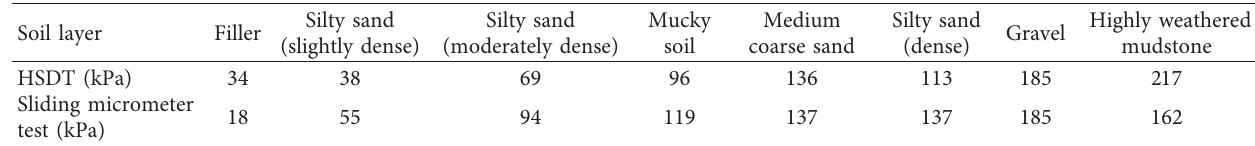
Table 5: Average values of pile side resistance in different soil layers at the soft rock bearing stratum site.